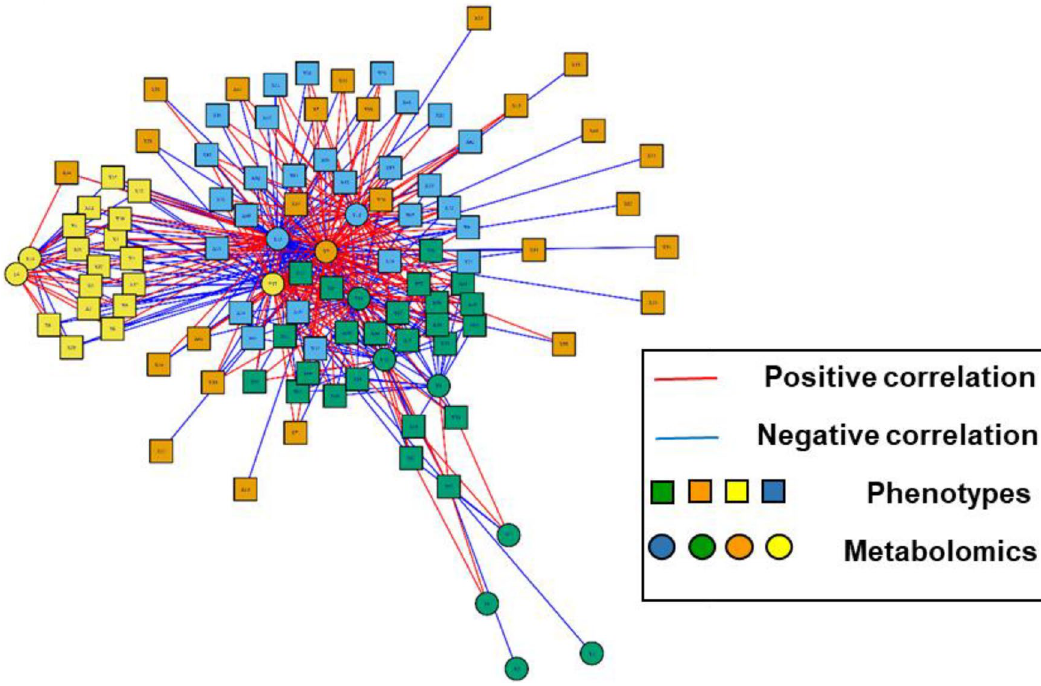
Figure 4. Multidata network threshold showing the four distinct clusters; red edges: positive correlation, blue edges: negative correlation; square nodes: metabolites, circle nodes: phenotypes.